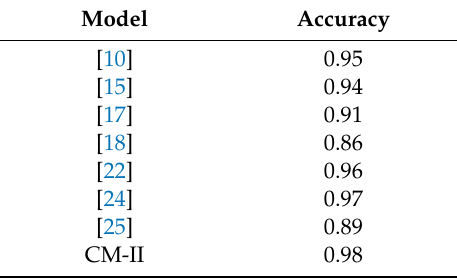
Table 4. Model Table 4. Model comparison.